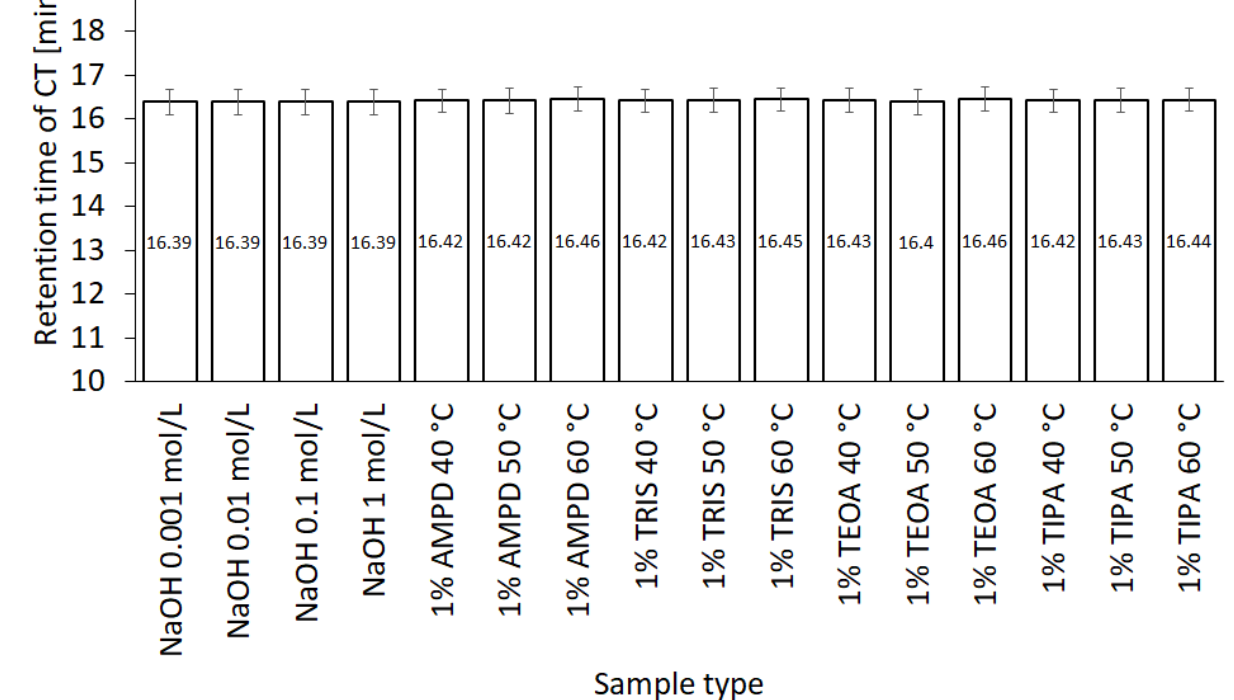
Figure 6. Variability of CT retention times in various solvents ( n = 3). The highest concentration of CT was observed in NaOH solutions of 1.0, 0.1, and 0.01 mol/L, respectively (Figure 7a), whereas the concentration of CT in 0.001 mol/L NaOH was close to the concentration of CT in 1% AMPD solution (Figure 7b). The CT concentrations in other alcoholamines, TRIS, TEOA, and TIPA, were ca. ten-fold lower than the CT concentrations in NaOH of 1.0, 0.1, and 0.01 mol/L concentrations. An increase in the values of CT concentrations was observed with an increase in the temperature of the solution prepared with alcoholamines (Figure 7b–d). Moreover, a decrease in the concentration of CT in NaOH solutions was noticed after 21 days, whereas in the case of CT in alcoholamine solutions, a decrease was observed after 42 days (Figure